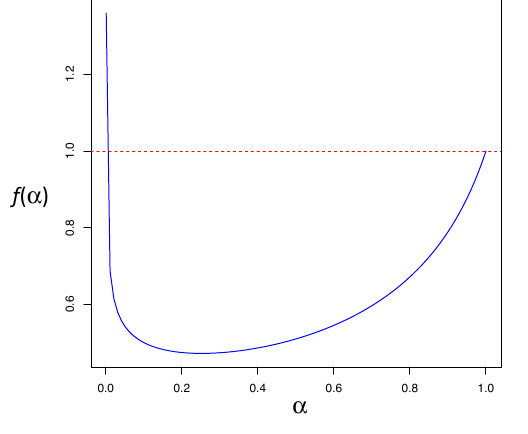
Figure 3. α vs. f (α) .